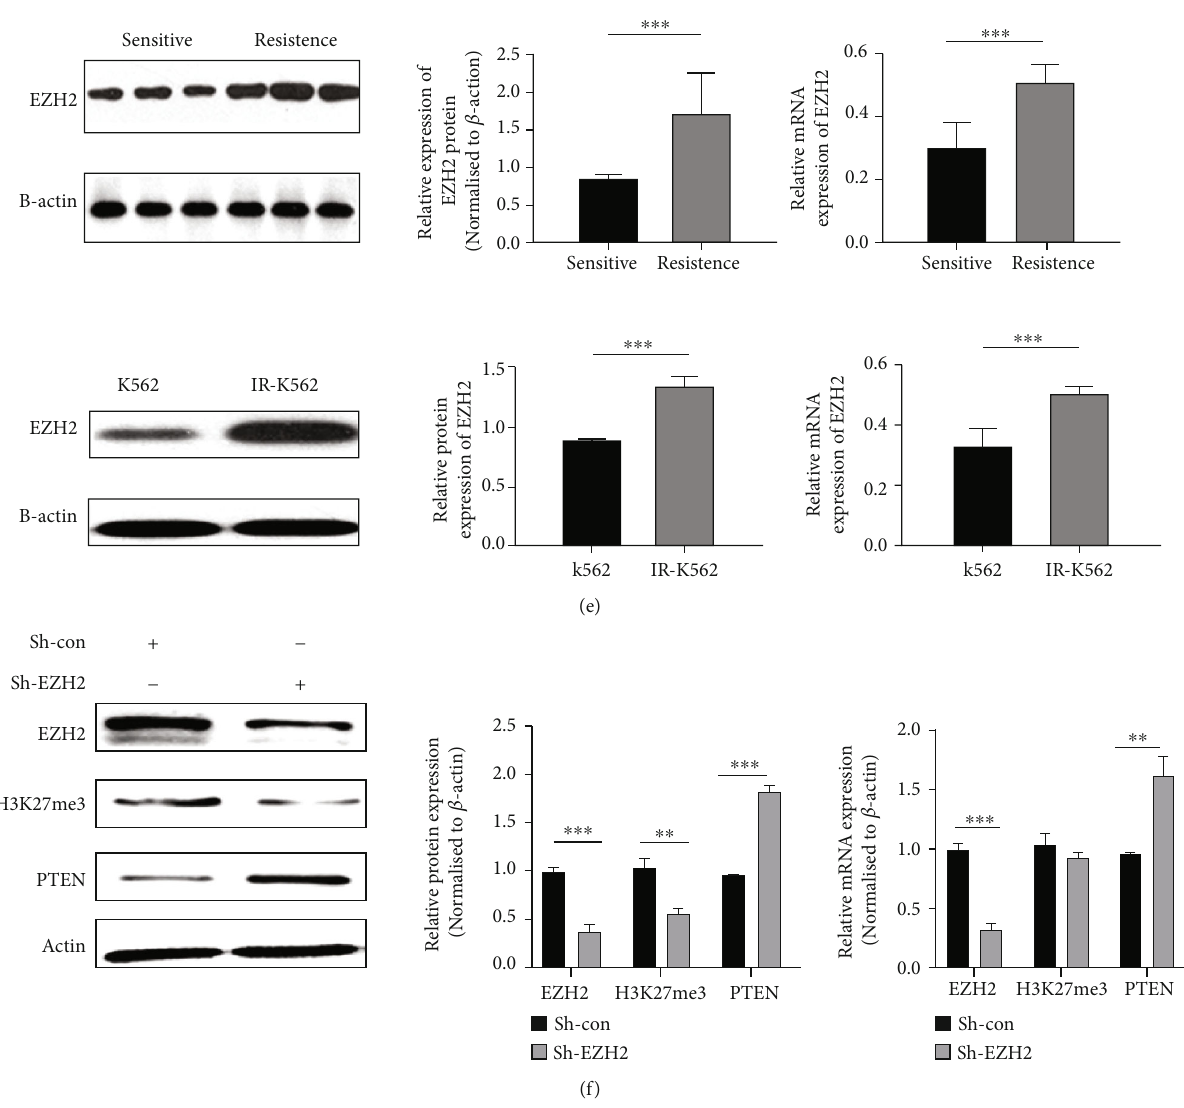
Figure 5: HOTTIP regulates EZH2 to inhibit PTEN expression. Note: (a) catRAPID predicted binding region of HOTTIP and EZH2. (b) FISH analyzed the localization of EZH2 and HOTTIP in IR-K562 cells. (c) RIP-PCR were used to test the interaction between EZH2 and HOTTIP. ∗ p < 0 : 05 vs. IgG. (d) RT-qPCR and Western blot were used to measure EZH2 mRNA and protein level after knocking down HOTTIP. (e) Western blot analysis was used to measure EZH2 in BM-MNCs of CML patients. Right panel, bar chart of protein densitometric analysis. ∗∗∗ p < 0 : 001 . RT-qPCR was used to detect EZH2 level in BM-MNCs of CML patients. Normalized to GAPDH. ∗∗∗ p < 0 : 001 vs. NC. Western blot analysis was used to measure EZH2 protein level in IR-K562 and K562 cells. Right panel, bar chart of protein densitometric analysis. ∗∗∗ p < 0 : 001 ; RT-qPCR was used to detect EZH2 mRNA level in CML cell lines (K562 and IR-K562). Normalized to GAPDH. ∗∗∗ P < 0 : 001 vs. NC. (f) RT-qPCR and Western blot were used to detect EZH2 and PTEN mRNA and protein levels after transfecting with speci fi c sh-con or sh-EZH2. ∗∗∗ P < 0 : 001 vs.